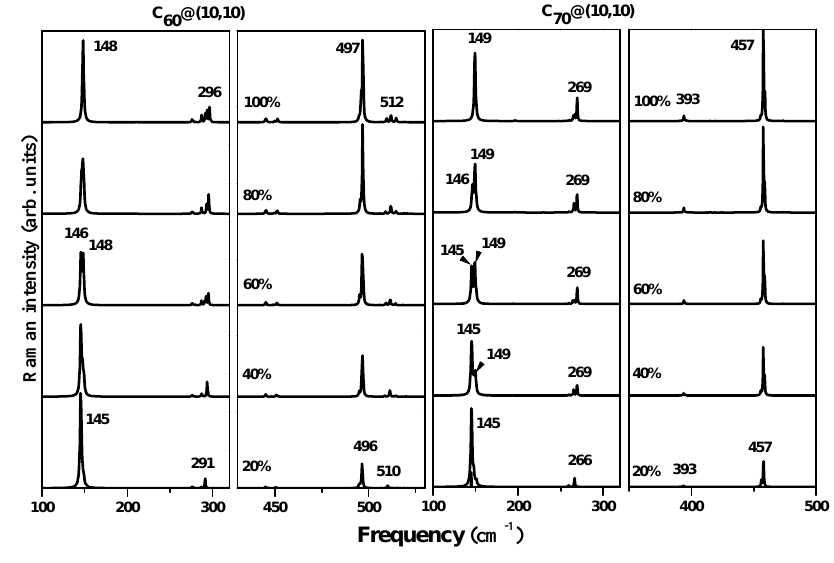
Figure 5. ZZ-polarized Raman spectra in RBLM regions for infinite nanopeapods as a function of their filling rate: C 60 @(10,10) (left) and C 70 @(10,10) (right).